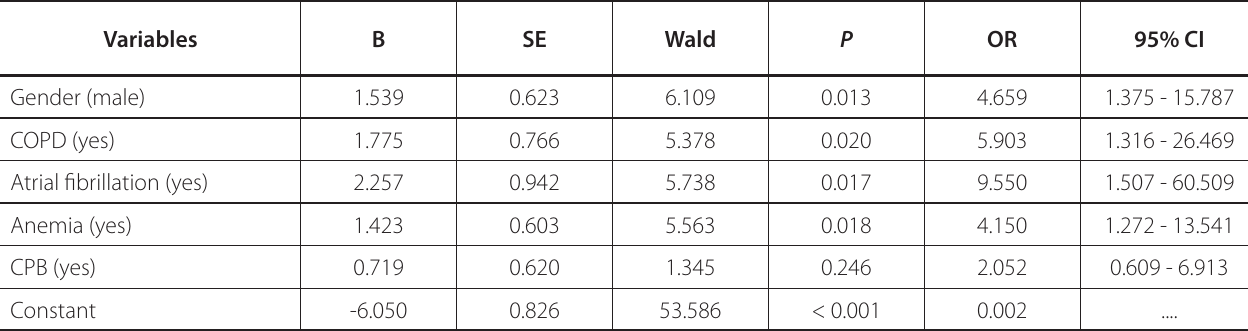
Table 2 . Logistic regression analysis. Variables